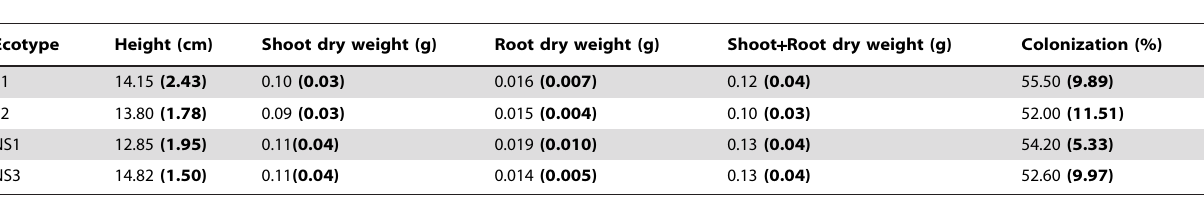
Table 1. Results of the harvest of Collinsia sparsiflora ecotype populations (S1, S2, NS1, and NS3) after being grown in a common garden of serpentine and non-serpentine AM